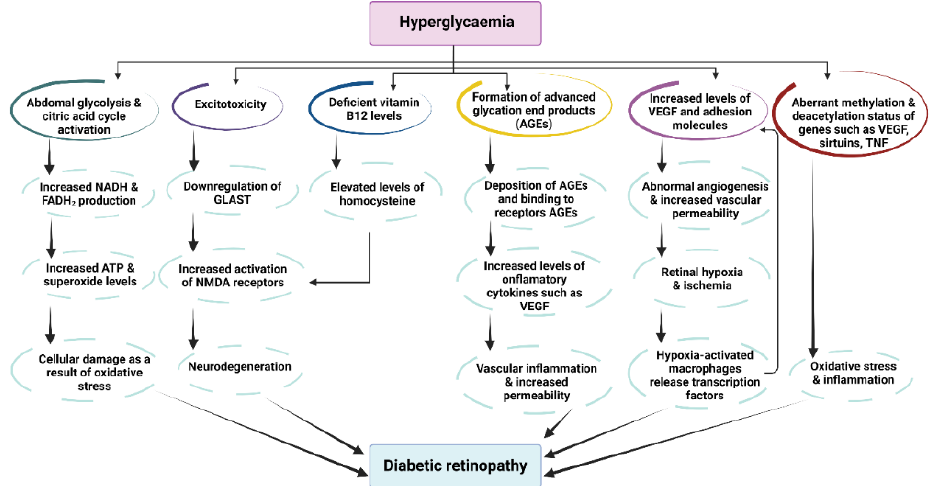
Figure 4. Pathophysiological pathways of diabetic retinopathy as a consequence of